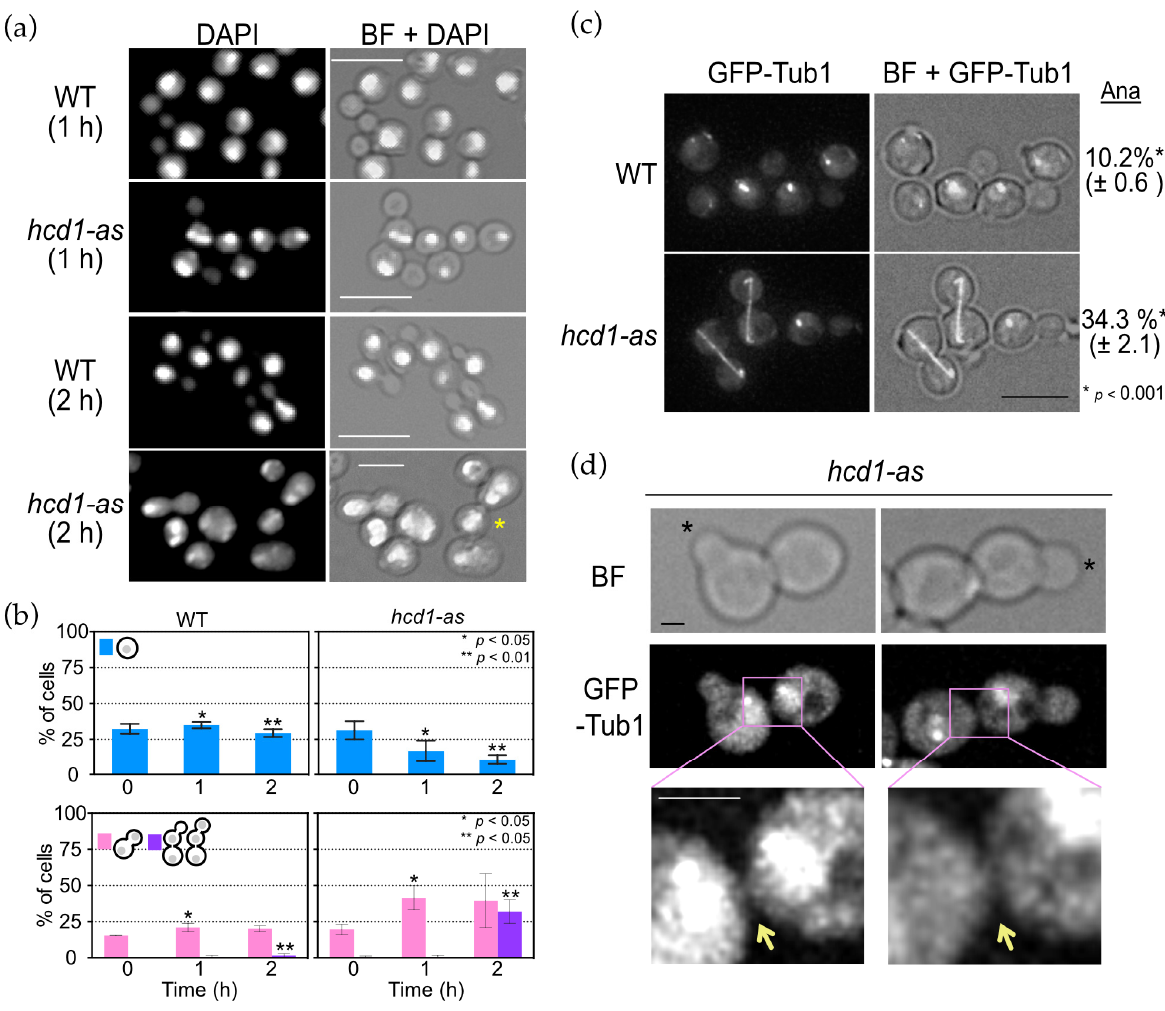
Figure 2. Hcd1-as cells have defects in mitosis and cytokinesis. ( a ) Logarithmically growing wild type (HPH1047) and hcd1-as (HPH1894) cells in YPDS medium were incubated with 5 µM 1NM-PP1 at 30 °C for the indicated time. Cells were fixed with 70% ethanol and DNA was stained with DAPI. BF, brightfield. Scale bar, 10 µm. Asterisks indicate unseparated cells. Scale bar, 10 µm. Note that cells are larger in hcd1-as (2 h). ( b ) Quantification of a. Upper graph: percentage of unbudded cells with one nucleus. Lower graph: percentage of large budded cells with two nuclei, one in the mother and the other in the bud, and unseparated large cell bodies with two or more nuclei. More than 100 cells were analysed at each time point. The experiment was performed in triplicate and the combined results are shown. Statistical significance of the differences between wild type and hcd1- as cells was determined by t -test and indicated by single or double asterisk. ( c ) Logarithmically growing wild type (HPH1968) and hcd1-as (HPH1969) cells carrying GTP-TUB1 in YPDS medium were incubated with 5 µM 1NM-PP1 at 30 °C for 1 h. Images were captured without fixation. Shown are projected images. BF, brightfield. Scale bar, 5 µm. Statistical significance was determined by the t -test. ( d ) Incomplete cytokinesis and cell separation of hcd1-as cells from the experiment in c. Aster- isks indicate newly formed buds. Yellow arrows point to the connections between mother and daughter cells of the last cell cycle. BF, brightfield. Scale bar, 1 µm. 3.3. Optimisation of iAID System for Analysis of Hcd2 Function In order to construct a conditional hcd2 mutant, we next considered conditional de- pletion of OpHcd2 protein. Our first attempt to use the auxin-inducible degron (AID) sys- tem, which was successfully used for OpCDC5 [28], did not generate a conditional mutant (Figure S8). We then attempted to establish a more efficient gene depletion method that is